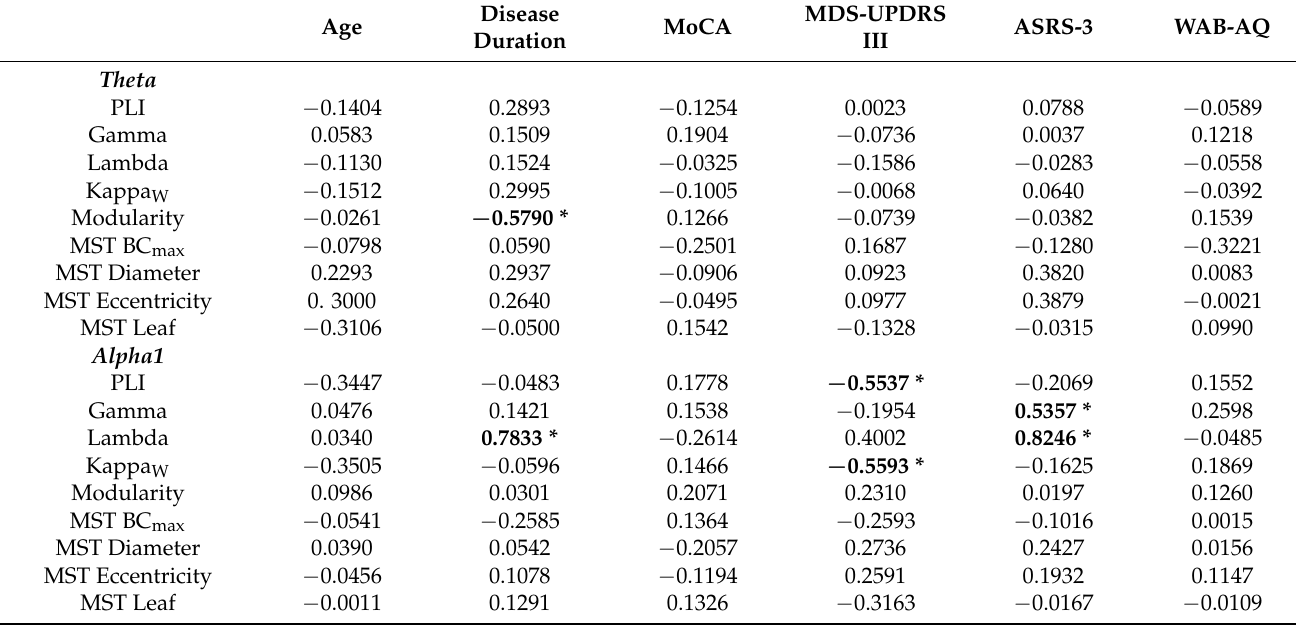
Table 4. Non-parametric Spearman correlations between graph theory network and behavioral variables of